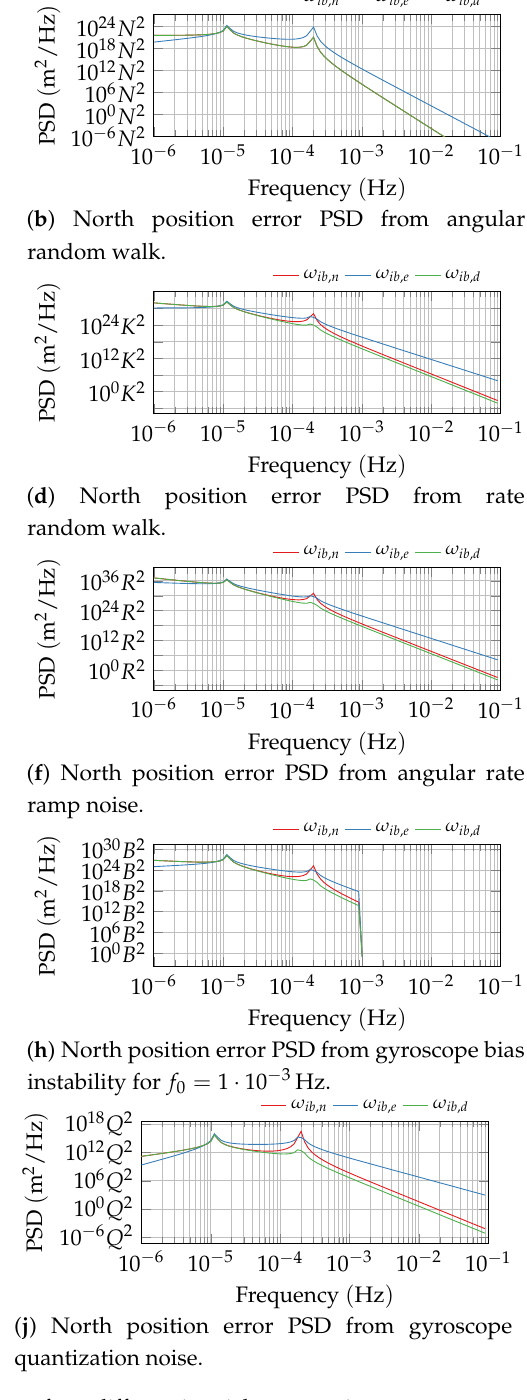
( b ) North position error PSD from angular random walk.